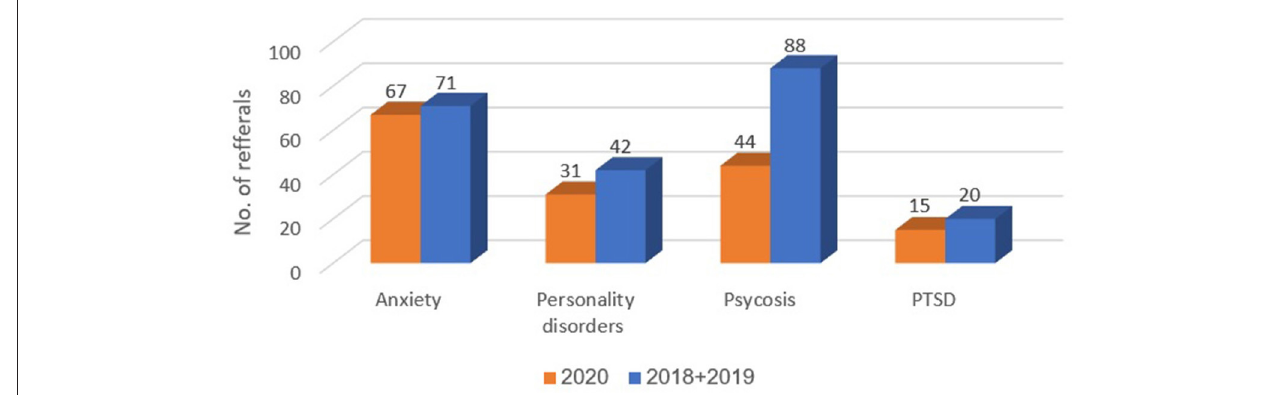
FIGURE 2 | Representation of diagnoses that increased in proportion of occurrence.